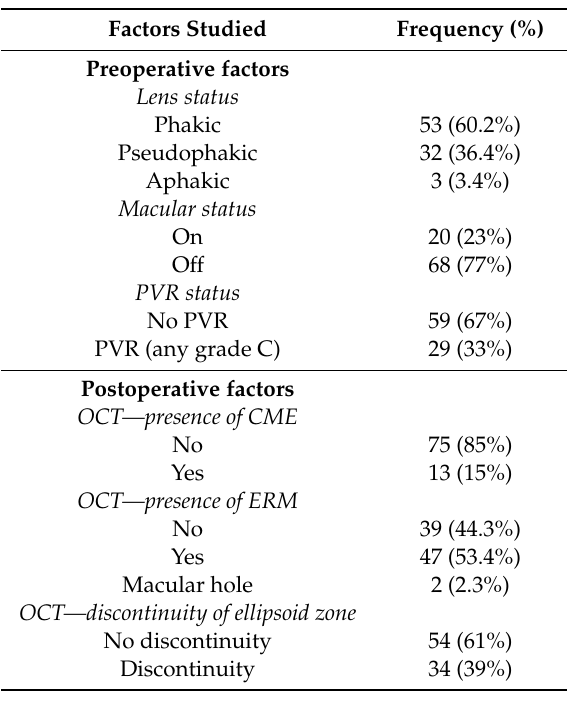
Table 2. Pre- and post-operative ocular variables of patients included in the